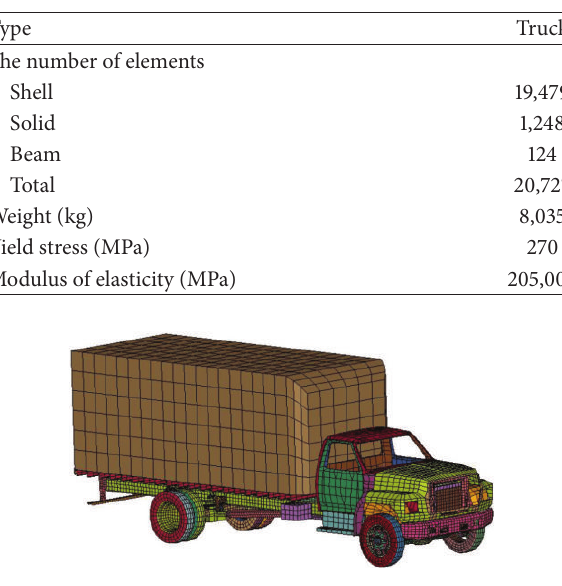
Table 2: Properties of truck model.